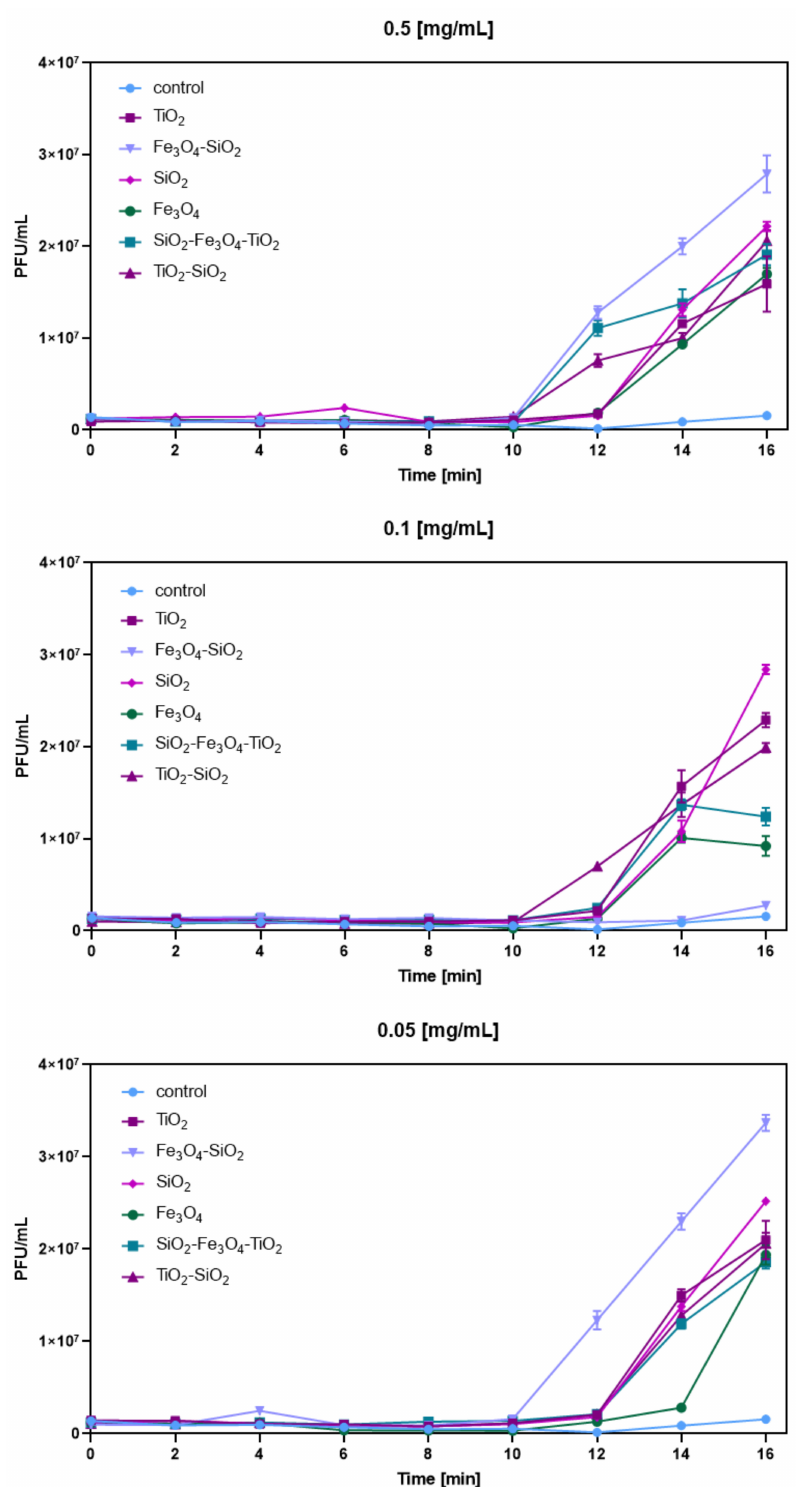
Figure 4. Bacteriophage T4 5 eclipse periods in the presence of selected nanoparticles At concentrations of 0.5 mg/mL, 0.1 mg/mL and 0.05